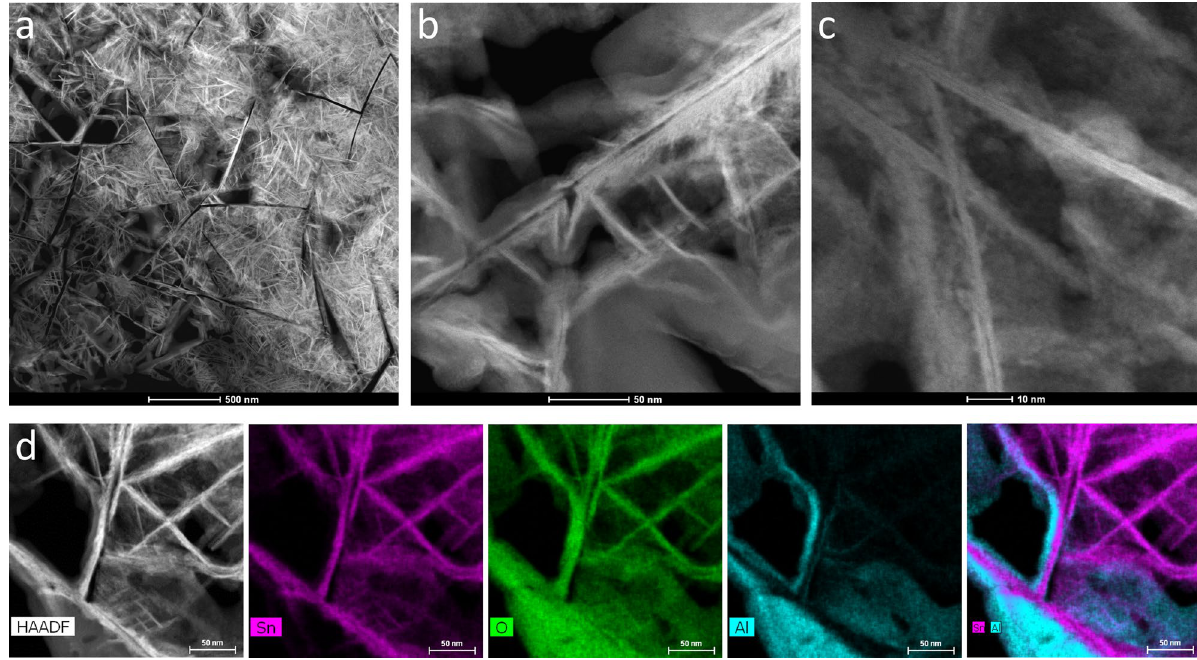
Figure 2. ( a ) Plane-observed HAADF-STEM image of the SnO 2 (101) nanosheet assembled film. ( b , c ) Magnified image of an area of ( a ). ( d ) HAADF-STEM image and its EDS mapping images for Sn, O, Al, and